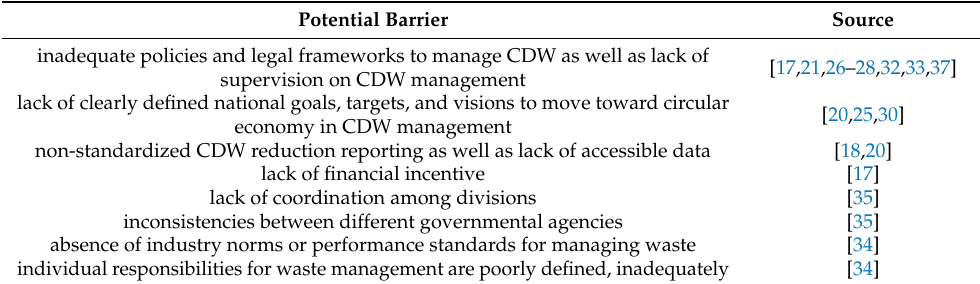
Table 4. Summary of legacy/policy barriers to increasing CDW recycling and re-using. Potential